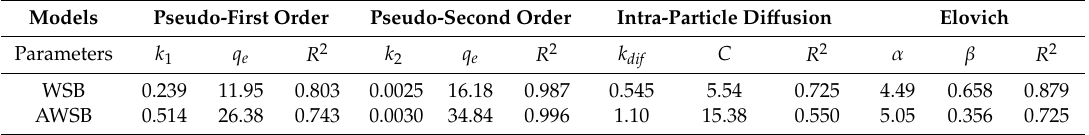
Table 3. Parameters of kinetic models at initial Cd concentration (25 mg / L), constant temperature